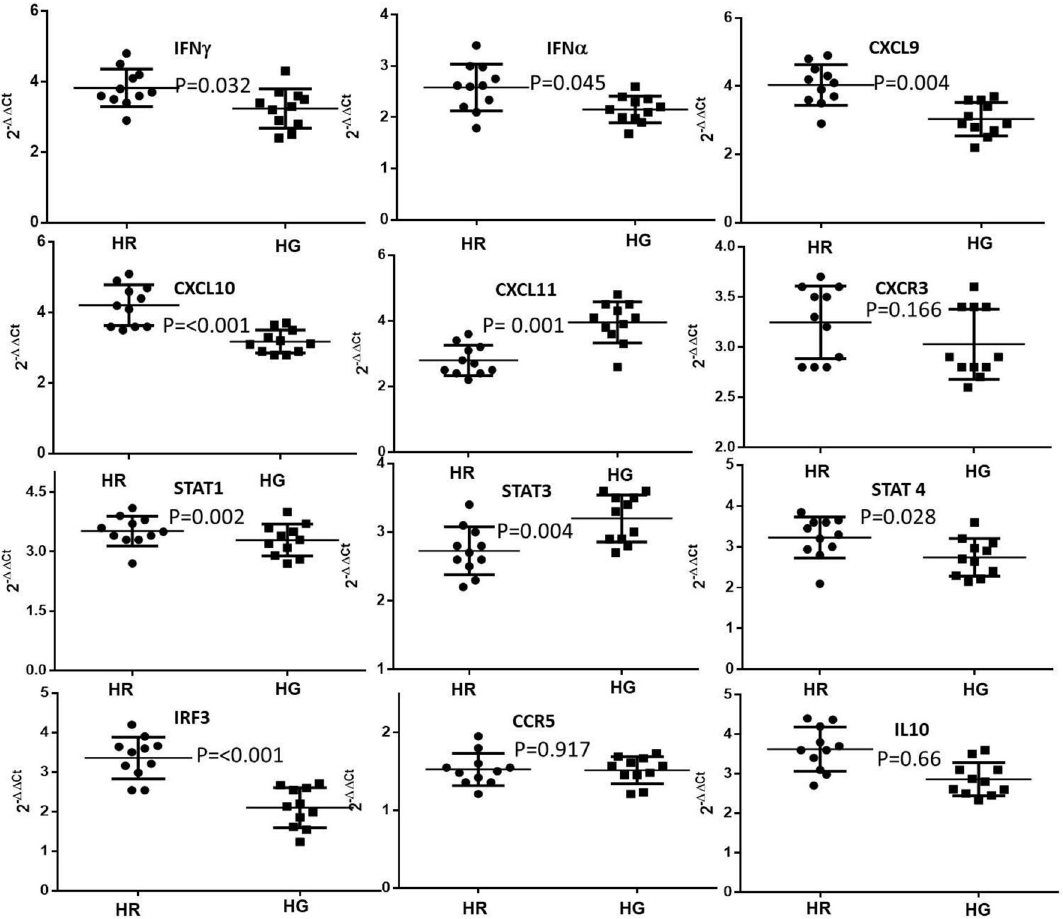
Figure 3. Differential mRNA expression of CXCR3-CXCL axis components from patients belonging to group 1 with either HCMV induced end organ retinitis (HR) or gastro-enteritis (HG) (N = 11). Their relative mRNA expression ratio with respect to group 3 control group (Baseline expression) in terms of fold change (2 −ΔΔCt ) were estimated by quantitative real time PCR. GAPDH mRNA served as internal control (+ 1 was considered to be the baseline of control, with values greater than 1 suggesting positive fold change and values below 1 upto 0 as negative fold